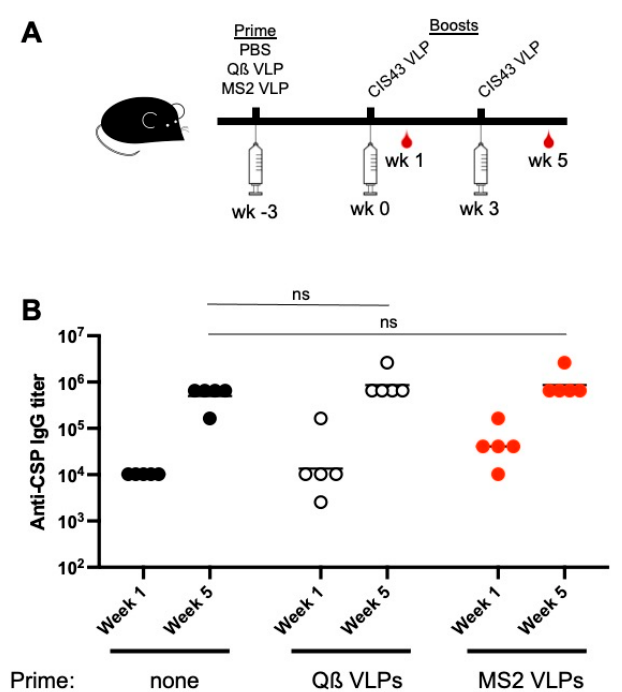
Figure 5. Pre-existing anti-platform immunity does not inhibit vaccine boosting in adult mice. ( A ) Experimental set-up. At week -3, adult mice were primed with PBS, or with 5 µ g Qß VLPs or MS2 VLPs. At weeks 0 and 3, mice were immunized with 5 µ g CIS43 VLPs. ( B ) Anti-CSP IgG endpoint titers from sera collected at weeks 1 and 5 were measured by ELISA. Each data point represents an individual mouse and lines denote the geometric mean titer of each group. Data were compared statistically by two-tailed t test using log-transformed values. ns, not significant.